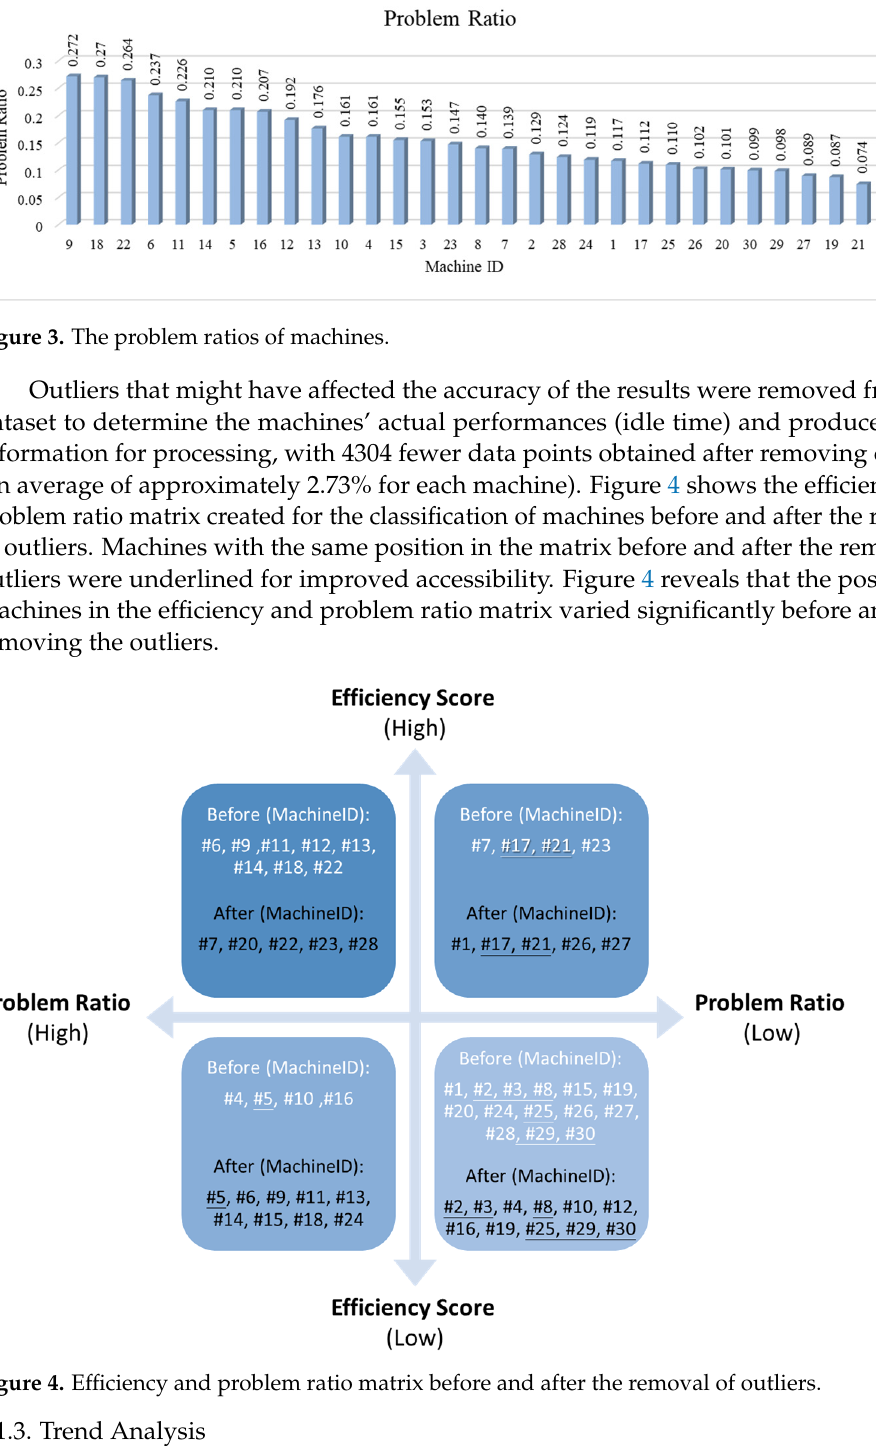
Figure 3. The problem ratios of machines.